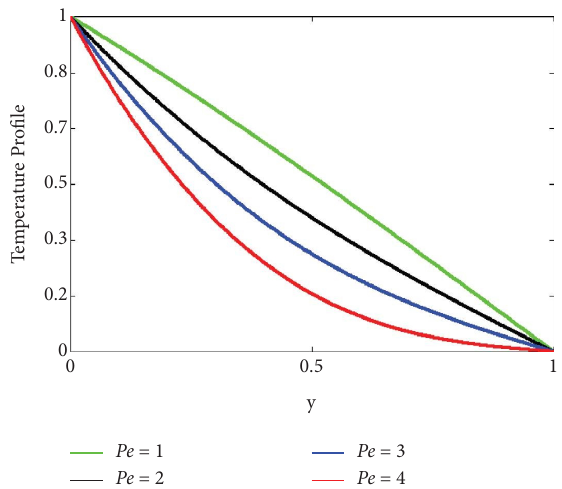
Figure 14: Te impact of diferent values of Pe on temperature.